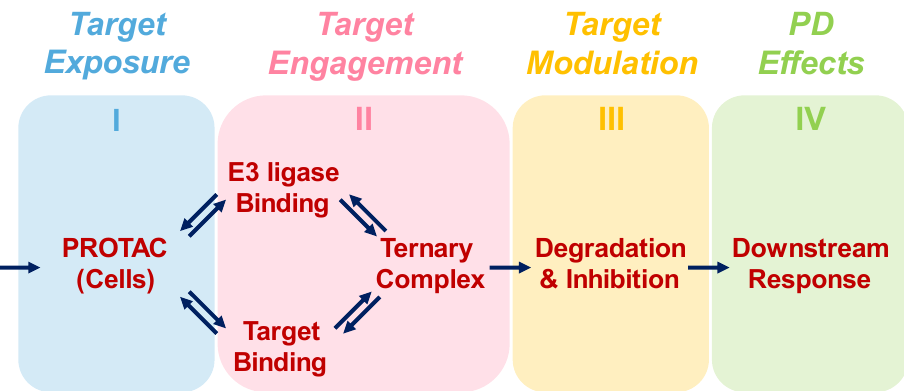
Figure 1. The concept of the four pillars of translational pharmacology is applied to PROTACs. First, the PROTAC has to get access to its site of action. Next, it must bind to both the target protein as well as the targeted E3 ligase to form a ternary complex. That ternary complex must then mark the target protein for degradation by the proteasome. Finally, degradation of the target protein together with inhibition of what activity remains must translate to the relevant downstream effect.